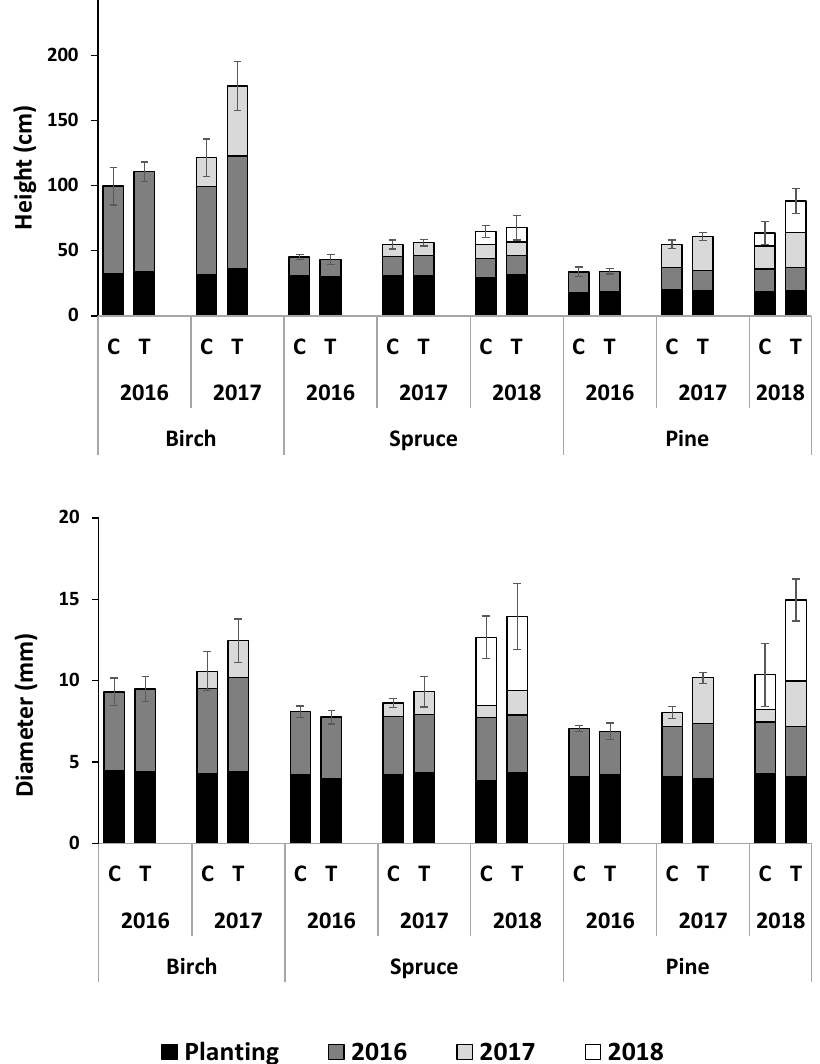
Figure 2. Total height and diameter of silver birch, Norway spruce and Scots pine seedlings harvested in different years (2016, 2017 and 2018) under warming treatment (T) and ambient (C) conditions. The x -axes contain the years of harvesting, the colors defining the growth of seedlings in each year before their harvest. The bars represent mean values ± standard deviation (SD).